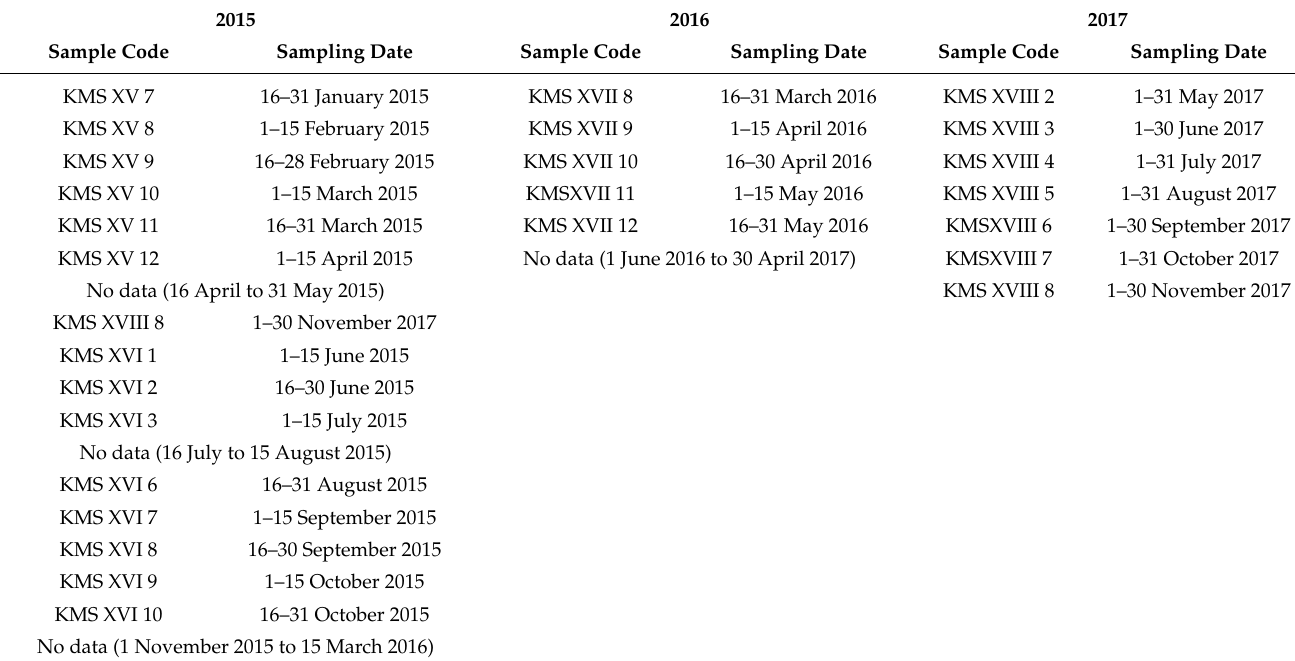
Table 1. Time intervals and sample codes of the analyzed sediment trap